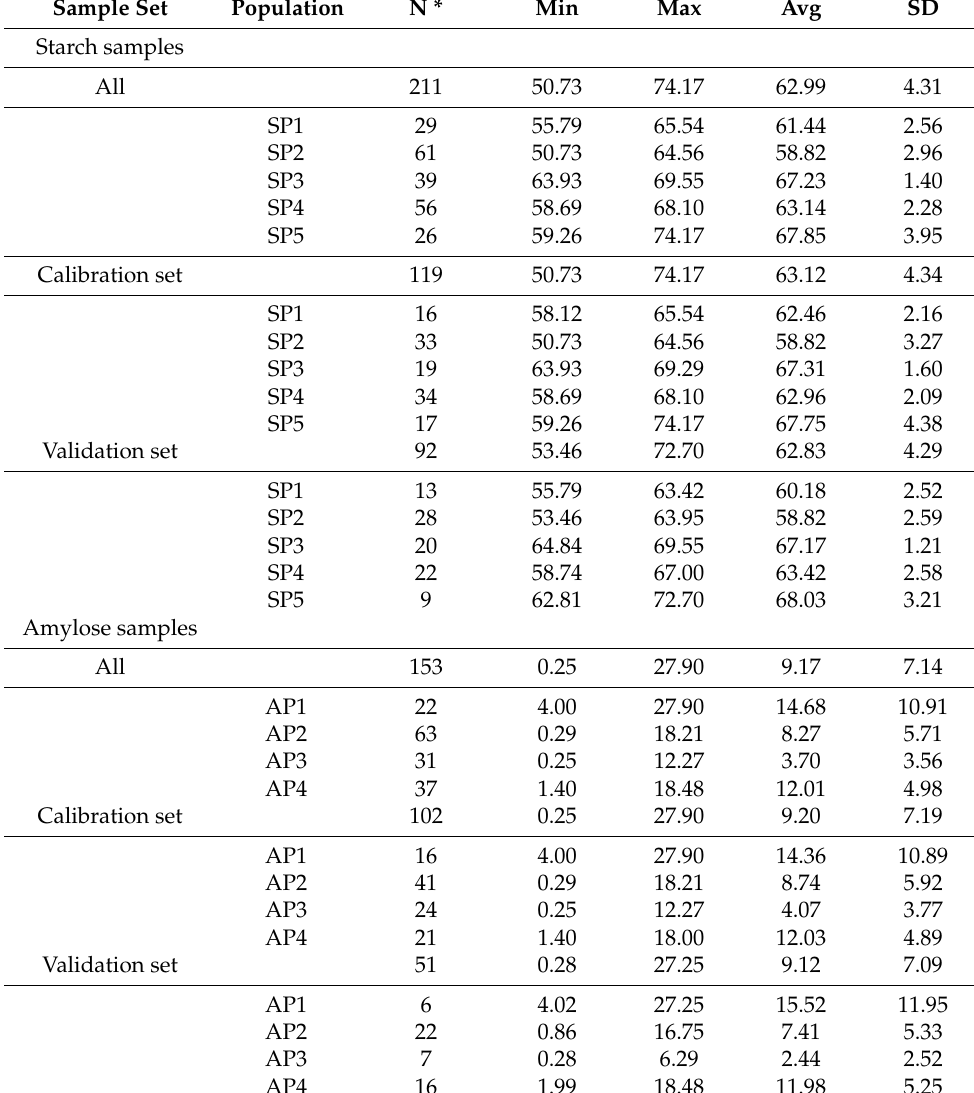
Table 2. Starch and amylose content variability in grain sorghum populations and in calibration and validation